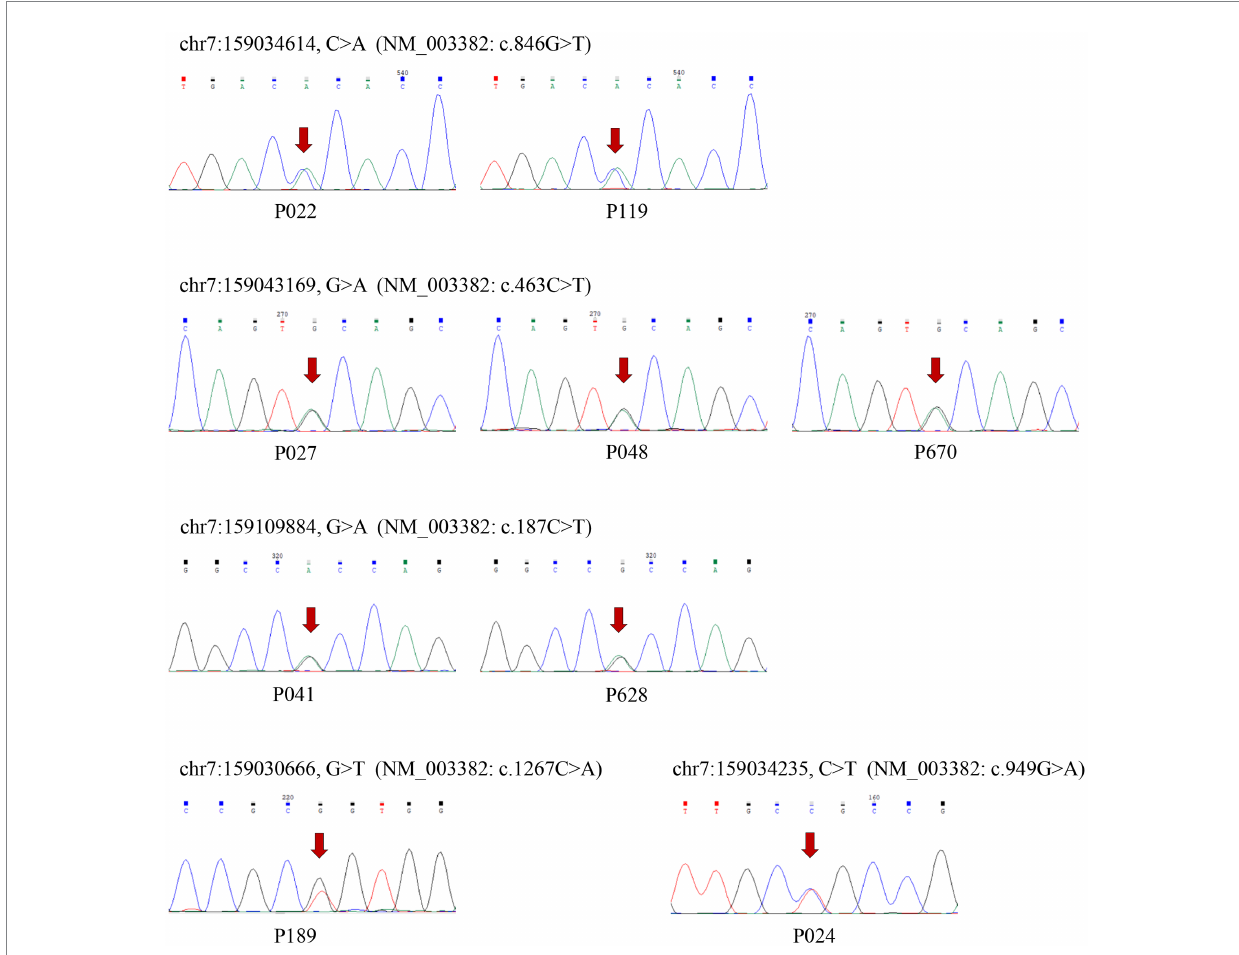
FIGURE 3 The results of Sanger sequence verifying the rare non-synonymous variants. The six variants were newly reported and arrows indicate the mutation